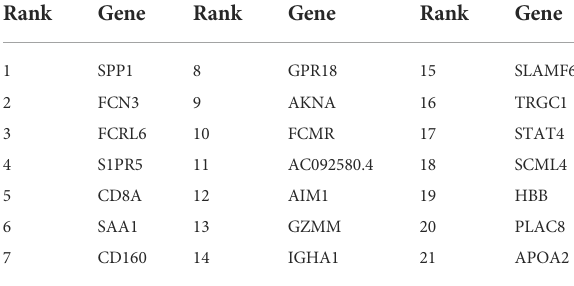
TABLE 1 The 21 optimal HCC biomarker genes got from IFS